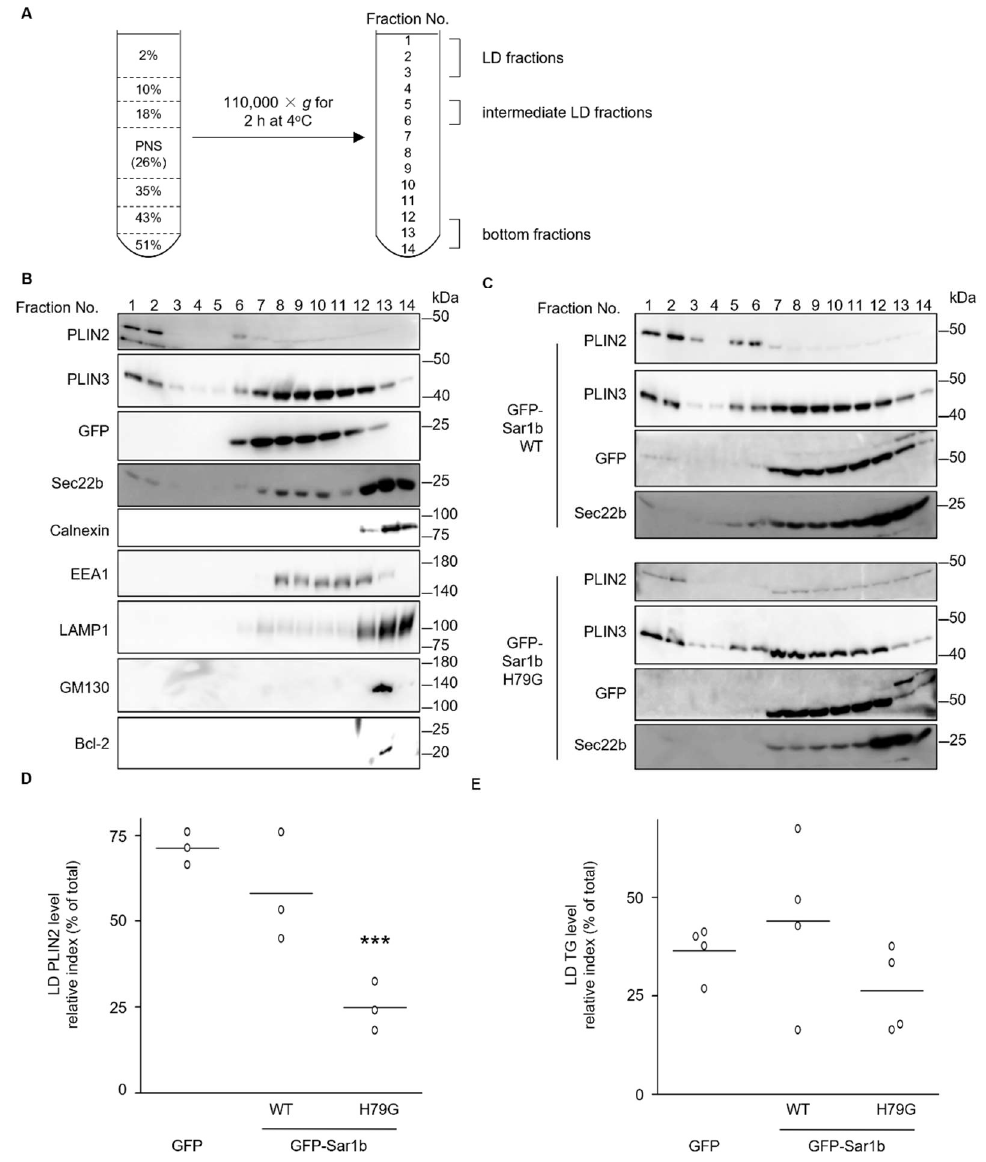
Figure 3. PLIN2 localization to lipid droplet in cells expressing WT or a mutant form of Sar1. ( A ) A scheme of sucrose density gradient centrifugation in this study. Post-nuclear supernatant (PNS) adjusted to 26% sucrose was placed in the middle of 2–51% gradient. After centrifugation, samples were recovered from the top into 14 fractions. Fractions 1 and 2, 5 and 6, and 12 to 14 were defined as LD fraction, intermediate LD fraction, and bottom fraction, respectively. The PNS fraction loaded before the centrifugation corresponds to fraction 7 to 10. ( B , C ) Lysates from cells treated with 0.5 mM oleic acid were fractionated by sucrose density gradient centrifugation, and an aliquot (10%) of each fraction was analyzed by western blotting using the antibodies to the indicated proteins. Lysates from cells expressing GFP ( B ), GFP-Sar1b WT, or GFP-Sar1b H79G ( C ) were fractionated. ( D ) The ratio of intensity of PLIN2 bands in the LD fractions (1 and 2) to that in sum of the all the lanes are shown as a scattered dot plot. *** p < 0.001 (vs GFP). ( E ) The ratio of TG levels in LD fractions to total cell lysate are shown as a scattered dot plot. p- Values for GFP vs. GFP-Sar1b WT; and GFP vs. GFP-Sar1b H79G were 0.919 and 0.487, respectively.